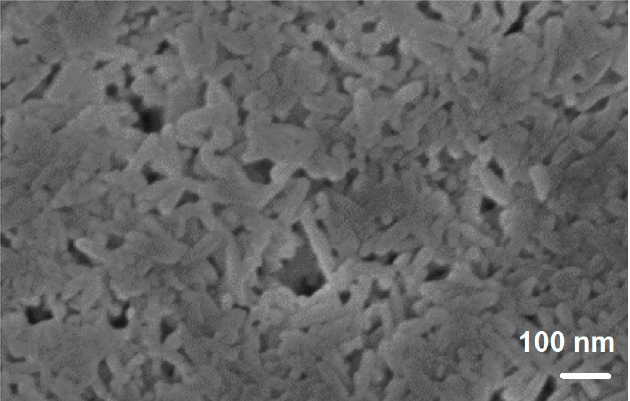
Figure 20. Surface of the partially densified hydroxyapatite sample perpendicular to the direction of applied load, SPS temperature 150 °C. Reprinted from Ortali et al. [58], Copyright (2017), with permission from Elsevier.